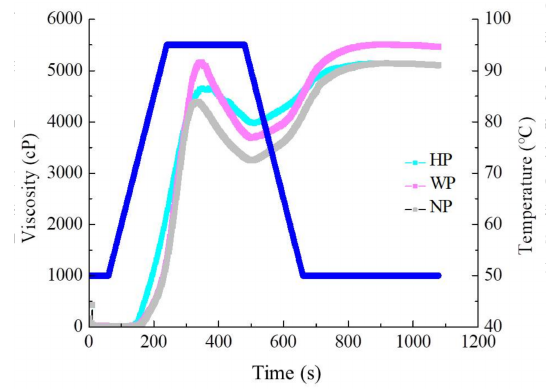
Figure 4. Rapid Visco Analyzer (RVA) viscoamylogram of djulis starch by the (1) hydrochloric acid isolation procedure (HP); (2) deionized water isolation procedure (WP); and (3) sodium hydroxide isolation procedure (NP) for djulis